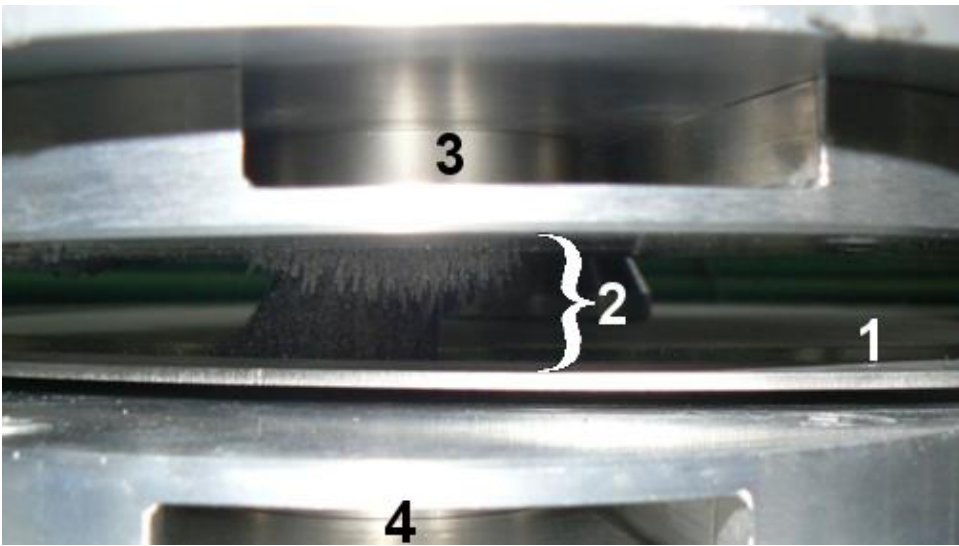
Figure 8. The shaped abrasive tool during the machining: 1—work piece, 2—flexible abrasive tool, 3,4—permanent magnets.